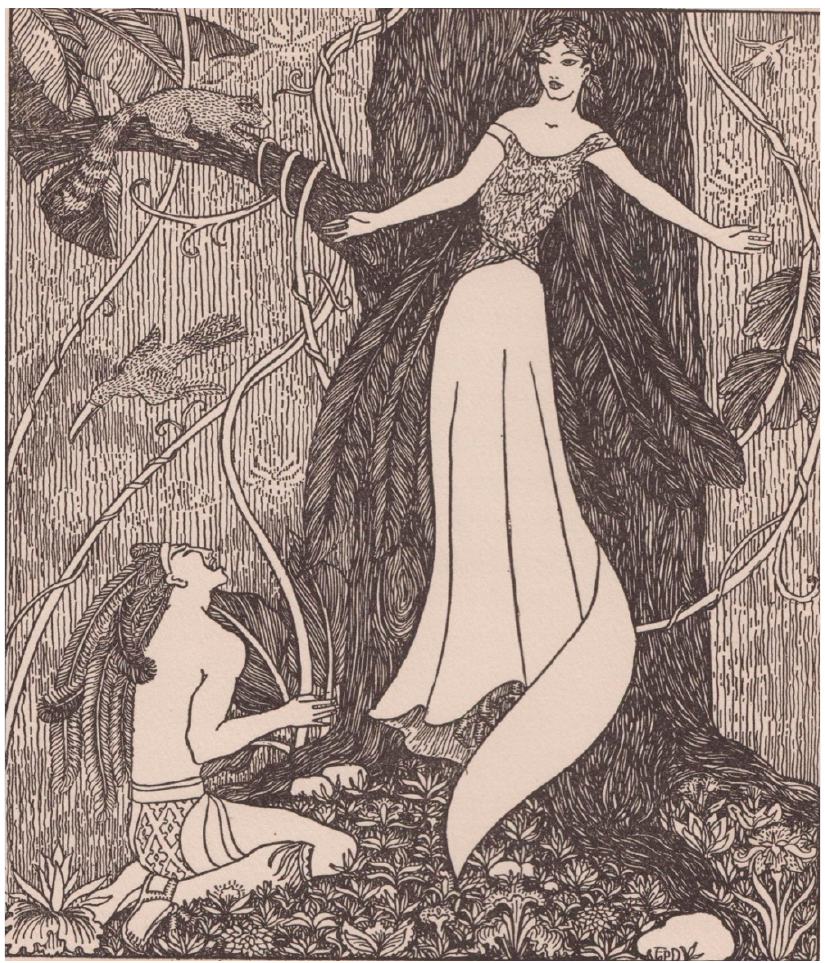
Figure 3. Frances Purnell Dehlsen’s illustration of the “Jungle Witch” (the Xtabay) from Idella Pur- nell’s (1931, p. 29). In the Public Domain. Purnell’s (1931, p. 29). In the Public